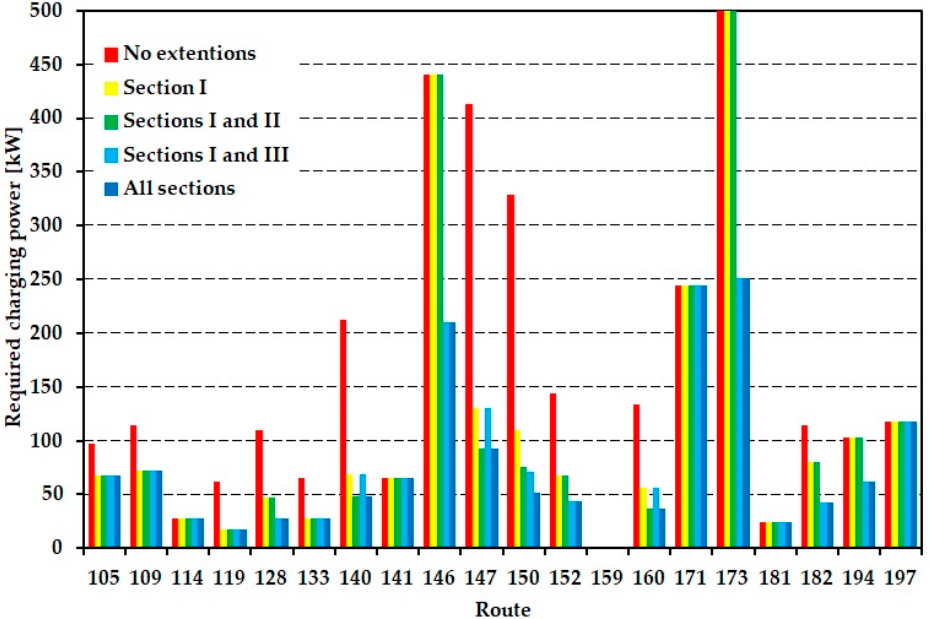
Figure 10. Values of the charging power which allow operating bus routes by IMC electric buses for several variants of trolleybus network extension with additional charging at the terminuses (source: own elaboration).